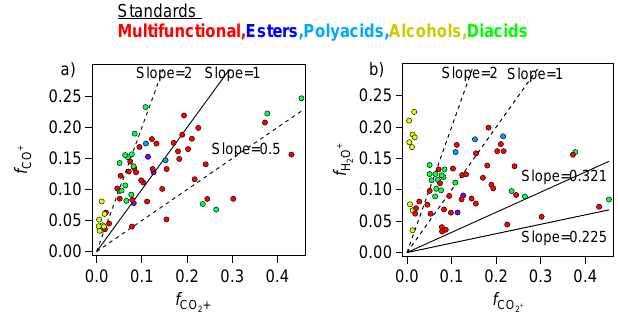
Figure 3. Scatterplots between AMS fractional ion intensities for CO + and CO + (panel a ) and H 2 O + and CO + (panel b ). The empir- 2 2 ical ratios used for each of these relationships in the Aiken-Ambient calculations are shown as solid lines with the appropriate slopes. In panel (b) , two solid lines are shown to reflect the measured ratios that correspond to possible H 2 O RIE values ranging from 1.4 to 2 (see Sect. 2 for more information). Dashed lines in both panels are included for reference to visualize the range of slope